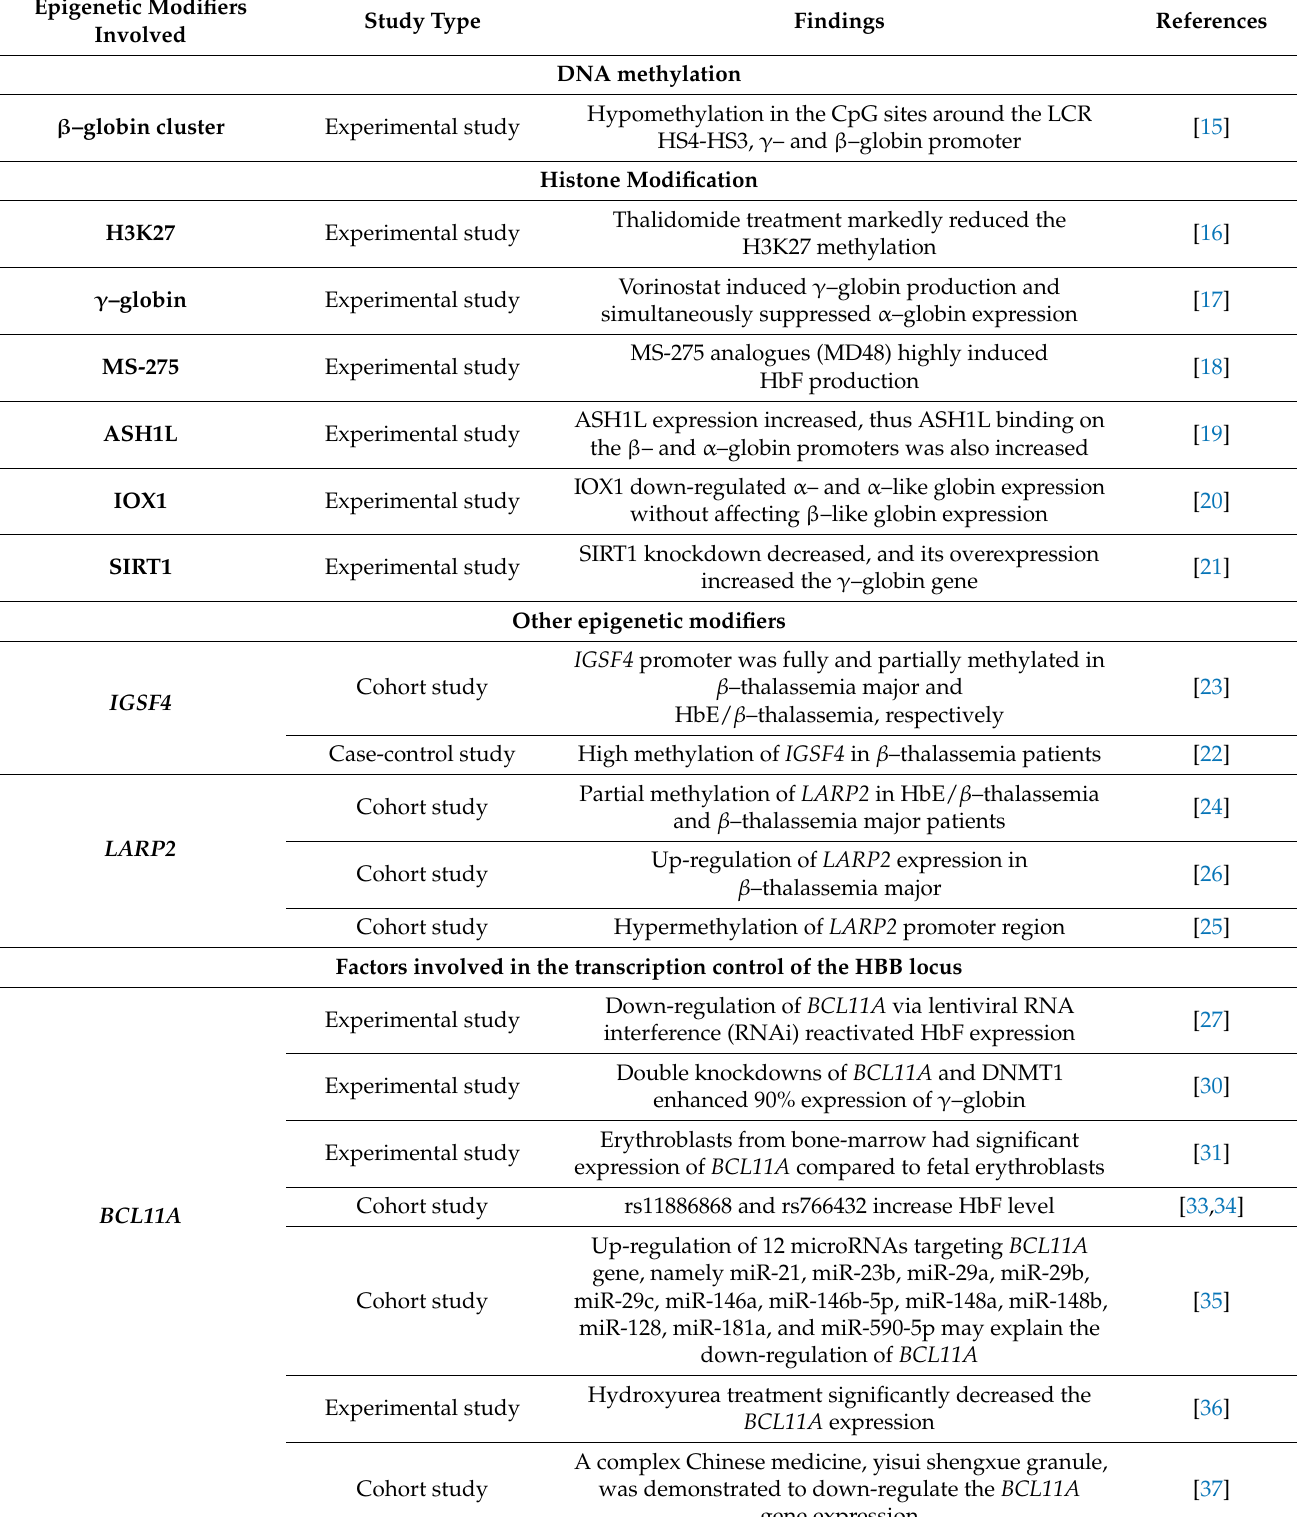
Table 1. Summary of the epigenetic modifiers involved in β